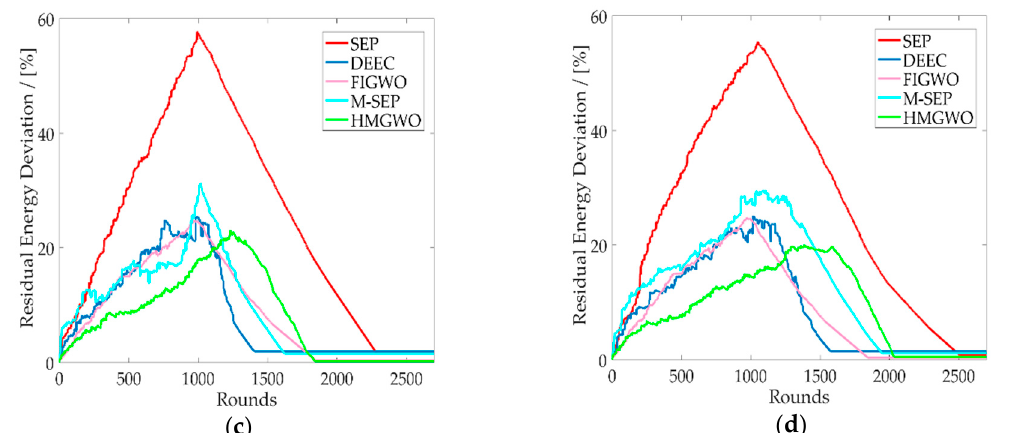
Figure 5. Residual energy relative to the number of rounds. ( a ) Total residual energy of HMGWO